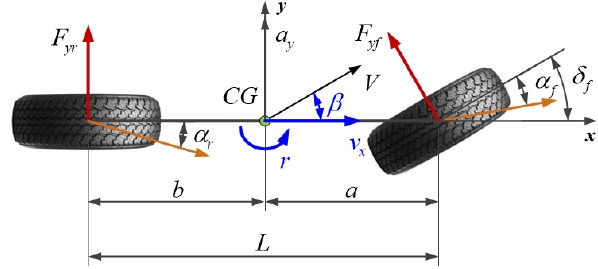
Figure 1. 3-DOFs vehicle dynamics